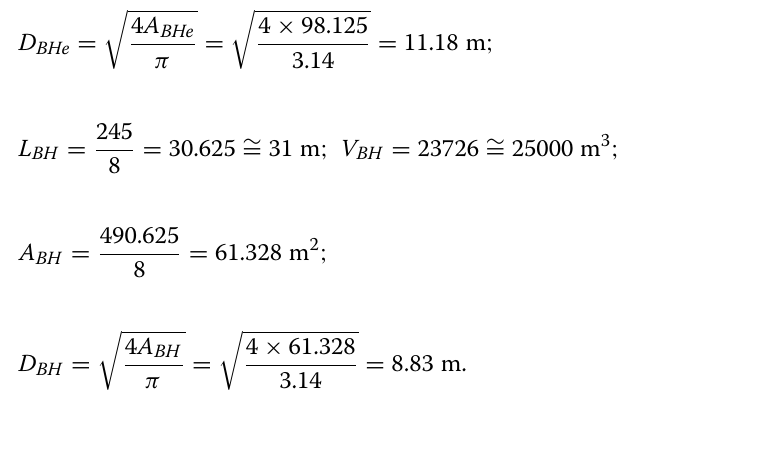
Placement of four large vertical wind turbines on a container ship as an alternative power